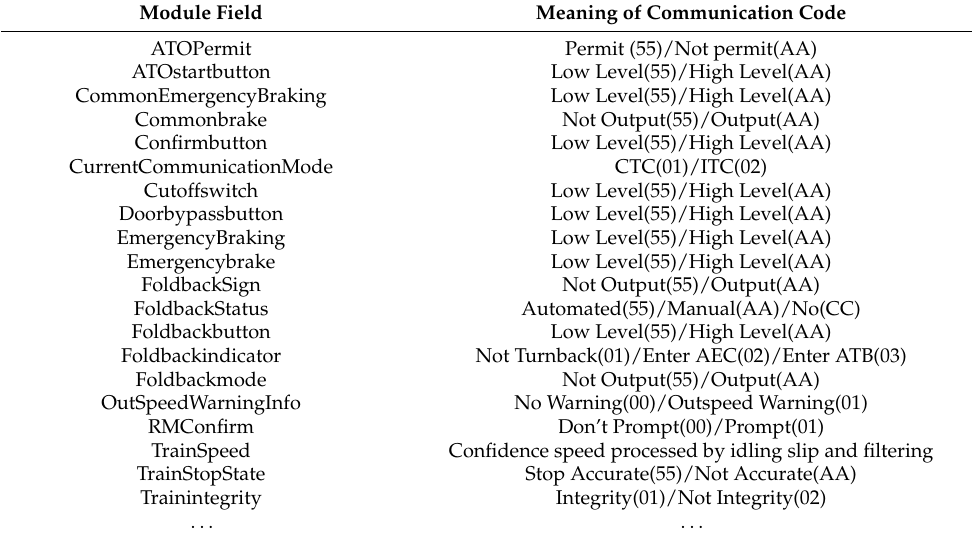
Table 1. Module field and meaning of communication